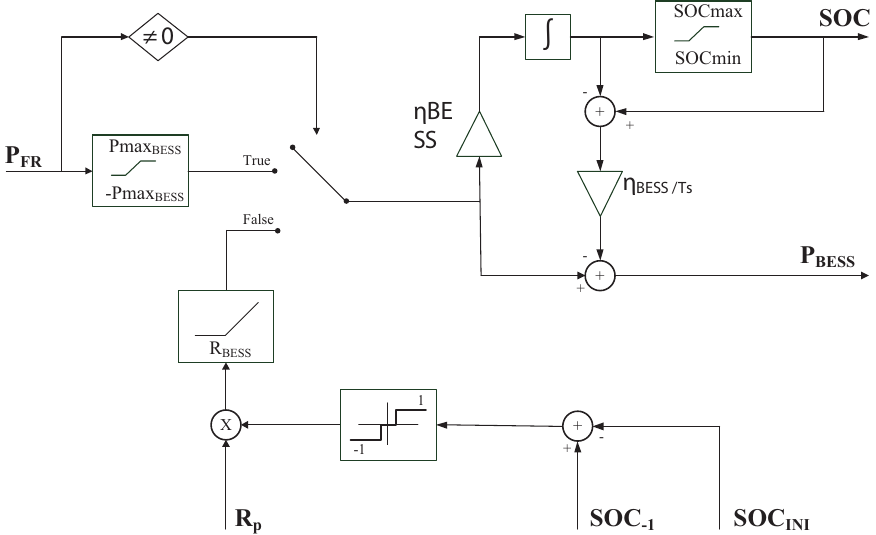
Figure 5. Battery energy storage system (BESS) control law. BESS power output ( P BESS ) tries to provide the necessary FR active power contribution ( P FR ). If there was not a required FR action, the BESS would recover its initial state of charge ( SOC ini